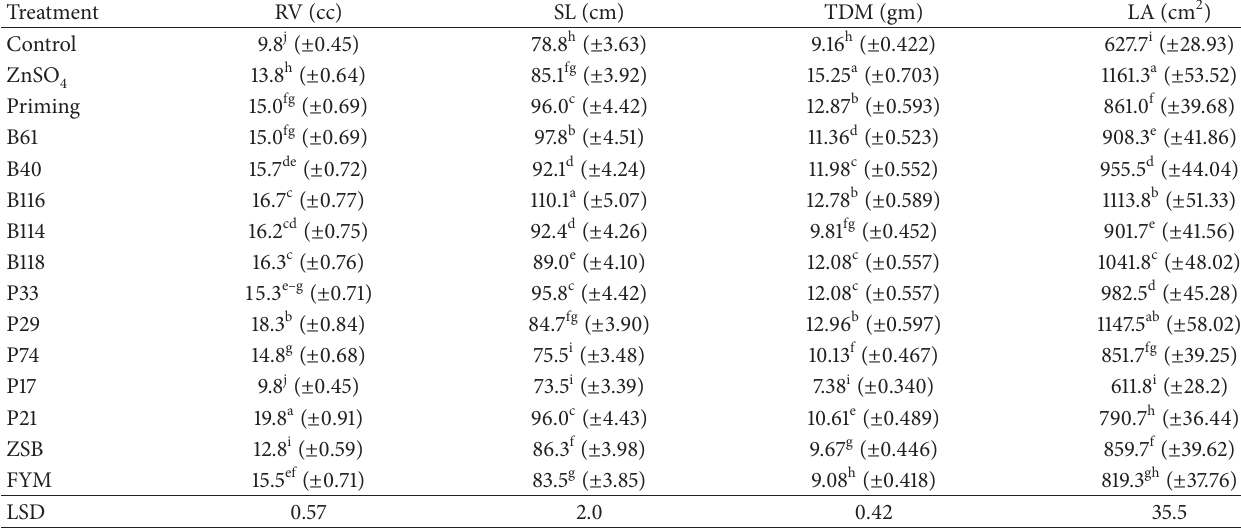
Table 2: Biometric growth parameters of maize seeds treated with ZSBs and inorganic source of zinc. Treatment